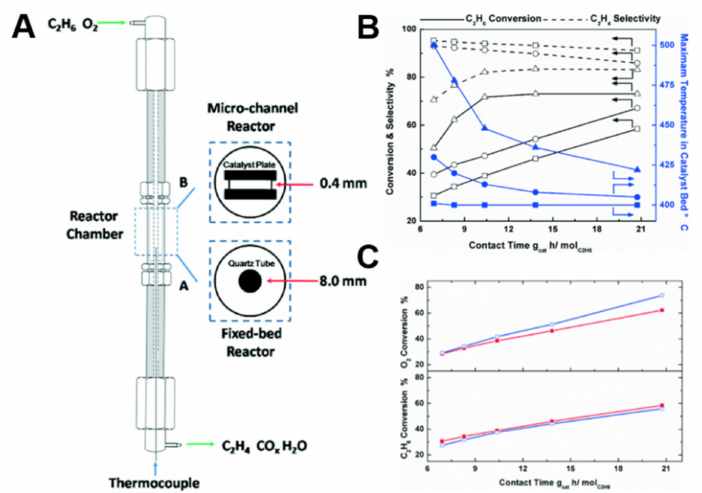
Figure 22. ( A ) Schematic diagram of the fixed-bed reactor and the micro-channel reactor. ( B ) Ethane conversion, ethylene selectivity, and hot spot temperature in the catalyst bed as functions of contact time for M1 catalyst powder in the fixed-bed reactor. Experiments were performed at 400 °C and 1.0 atm with a C 2 H 6 /O 2 /He molar ratio of 30/20/50 and a diluter-to-M1 catalyst mass ratio of (( ▴▵ ) 1:4, ( ● ○ ) 5:1 and ( ■ □ ) 10:1 at a reactor inlet. ( C ) Ethane and oxygen conversion as functions of contact time, M1 catalyst in the fixed-bed reactor ( ■ ) and in the micro-channel reactor ( □ ). Experi- ments were performed at 400 °C and 1.0 atm with a C 2 H 6 /O 2 /He molar ratio of 30/20/50 at the reactor inlet. Adapted from ref. [22], Copyright (2015), with permission from the Royal Society of Chemis- try.